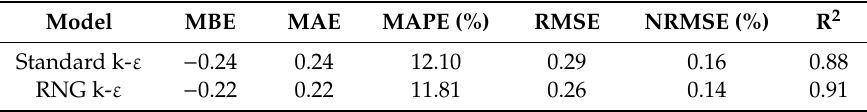
Table 2. Error indices of the numerical models for y t / ( d · F ).